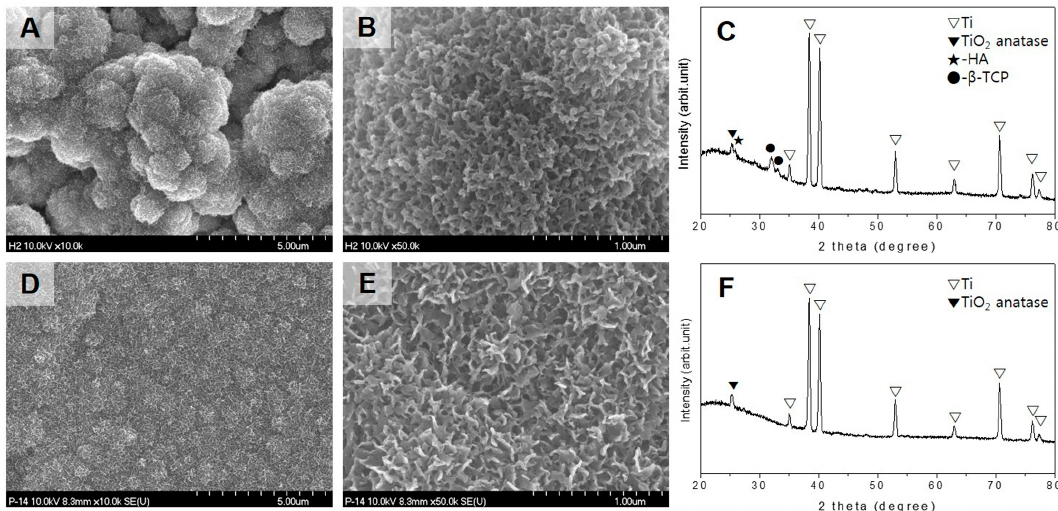
Figure 2. Bioactivity of Ti mesh after immersion in simulated body fluid (SBF) at 37 °C. Precalcified nanotubular Ti mesh (CP-AT) showed large and dense aggregates of crystalline structures on the surface ( A , B ) and hydroxyapatite (HA) and β -tricalcium phosphate ( β -TCP) peaks on XRD analysis after three days of immersion ( C ). Nanotubular Ti mesh (AT, anodized Ti mesh) showed small aggregates of crystalline structures ( D , E ) after 14 days of immersion; none of the HA peaks were observed on XRD analysis ( F ).